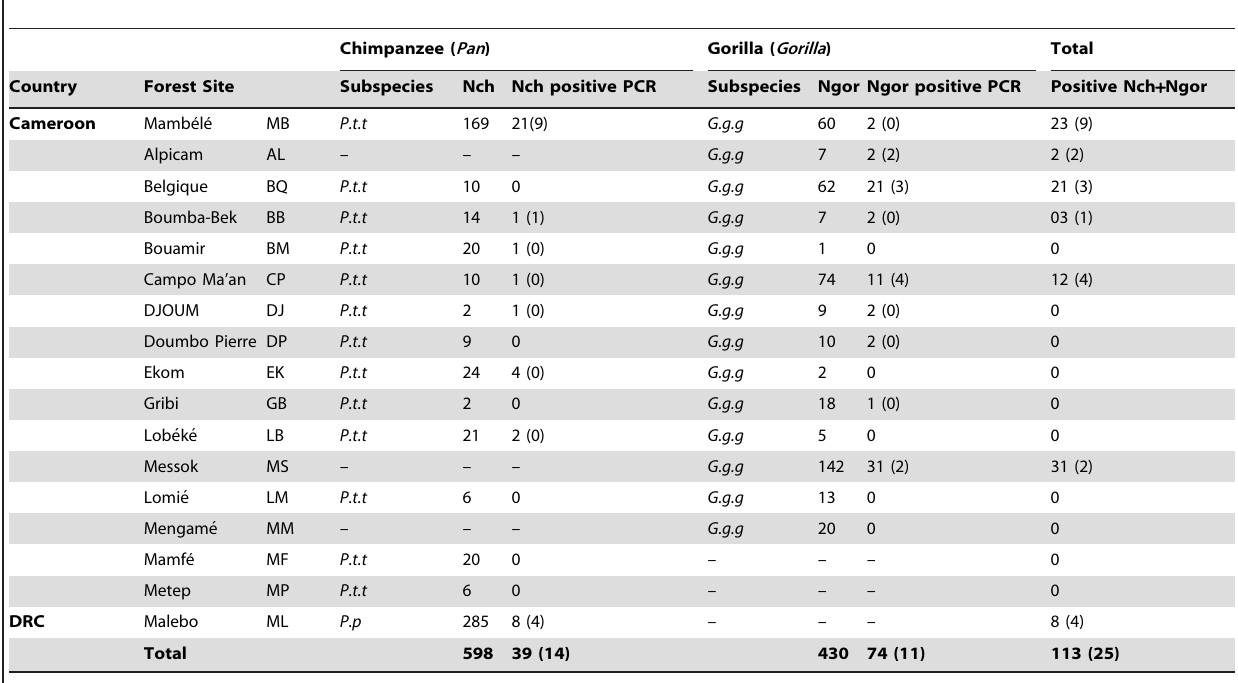
Table 1. Distribution of ape fecal samples according to the country and ape species.